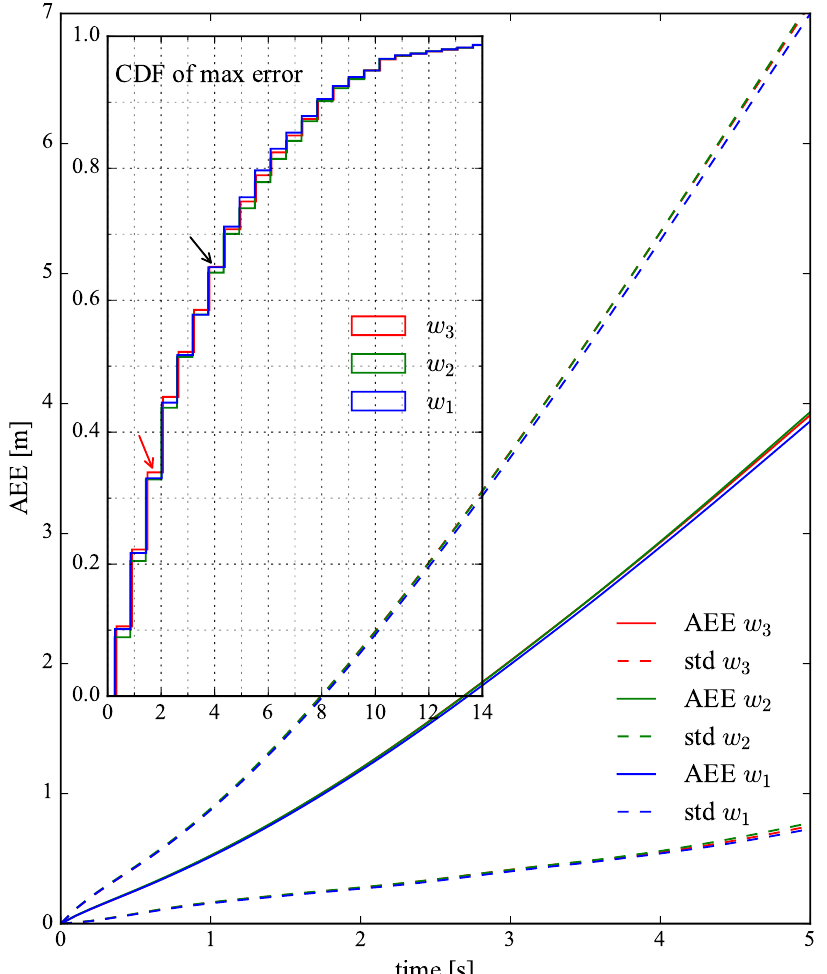
Figure 6. Statistics of position prediction errors. The solid and dotted lines are the AEEs and standard deviations (std) of position prediction errors, respectively. The red corresponds to the nonlinear IDW method w 3 ; the green corresponds to the AW method w 2 ; the blue corresponds to the linear IDW method w 1 . The IDW methods (red and blue) are slightly better than the AW method (green). The CDFs of max prediction errors when w 3 , w 2 , w 1 are used are plotted in the upper-left box. The red arrow indicates that w 3 yields more outstanding predictions. The black arrow indicates a good prediction rate of either weighting function in our algorithm of more than